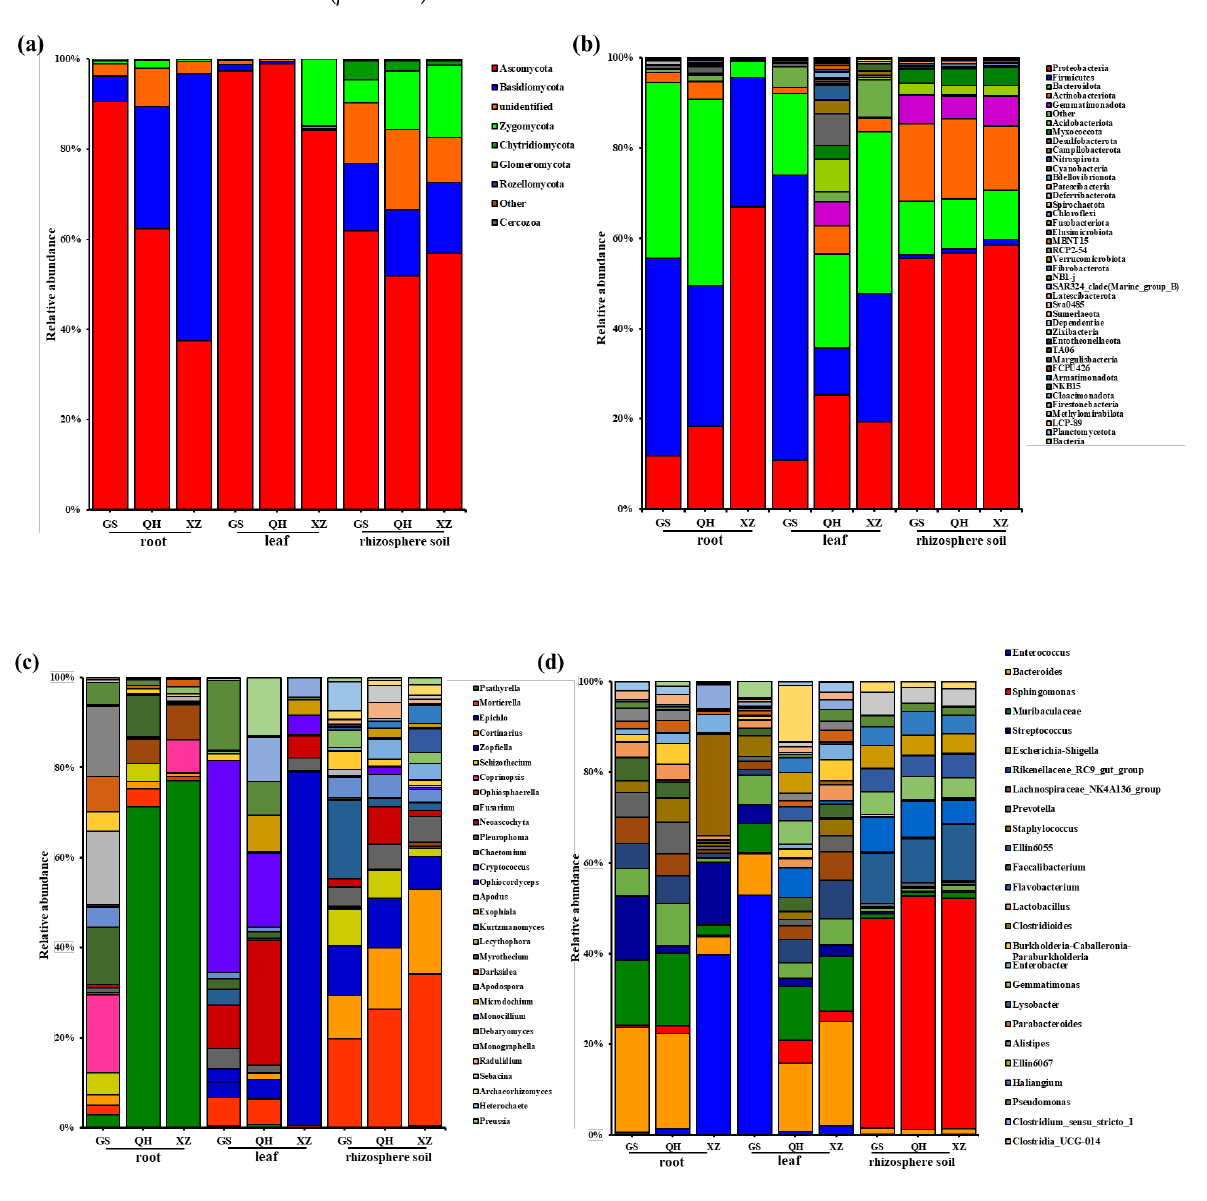
Figure 5. Relative abundance of fungal phyla ( a ), bacterial phyla ( b ), fungal genera ( c ), bacterial genera ( d ).